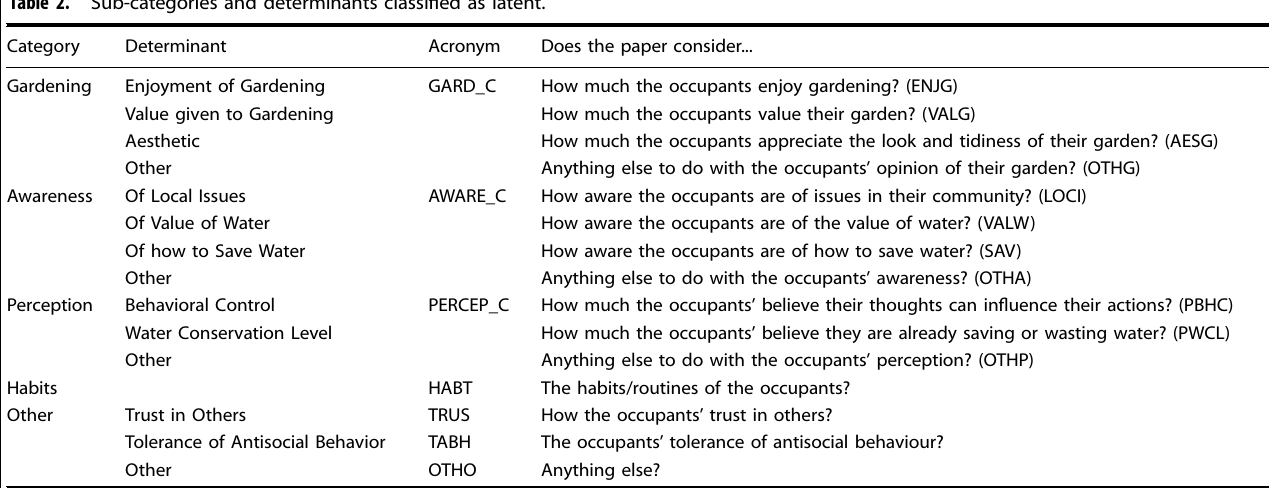
Table 2. Sub-categories and determinants classi fi ed as latent.